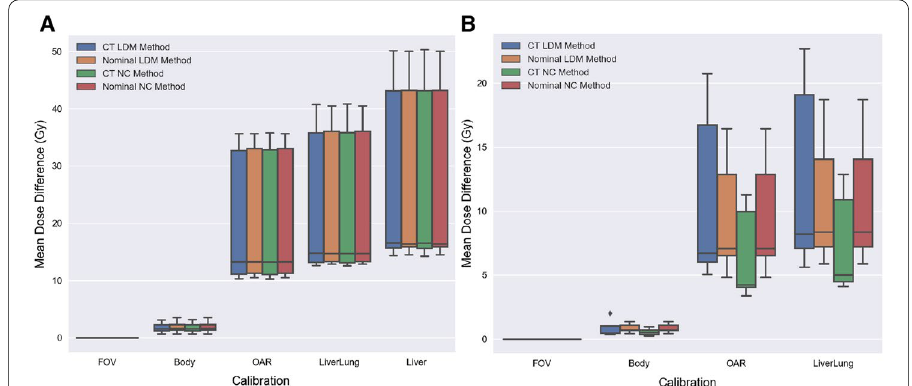
Fig. 3 Liver ( A ) and lung ( B ) absolute mean dose differences of each methodology relative to their own FOV calibration. The absolute mean dose difference between calibrations may be calculated by subtracting the calibration mean dose differences from one another